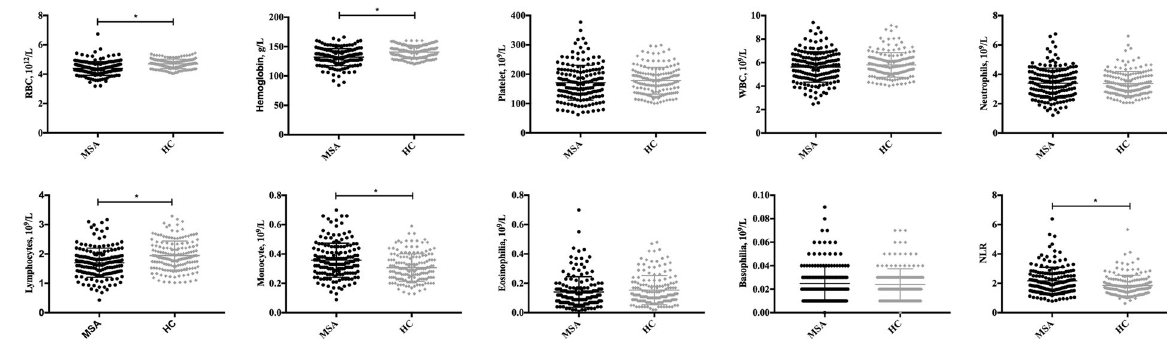
Fig. 1 Comparison of hematological data between MSA and HCs. The numbers of patients with MSA and HC were 169 and 163, respectively. The Mann – Whitney U test or Student ’ s t -test was performed. The p -value of the comparison of RBCs, hemoglobin, lymphocytes, and monocytes between MSA and HCs was <0.001. The p -value of the comparison of NLR between MSA and HCs was 0.001. MSA multiple system atrophy, HCs healthy controls. *Indicates signi fi cant differences after adjusting for a false discovery